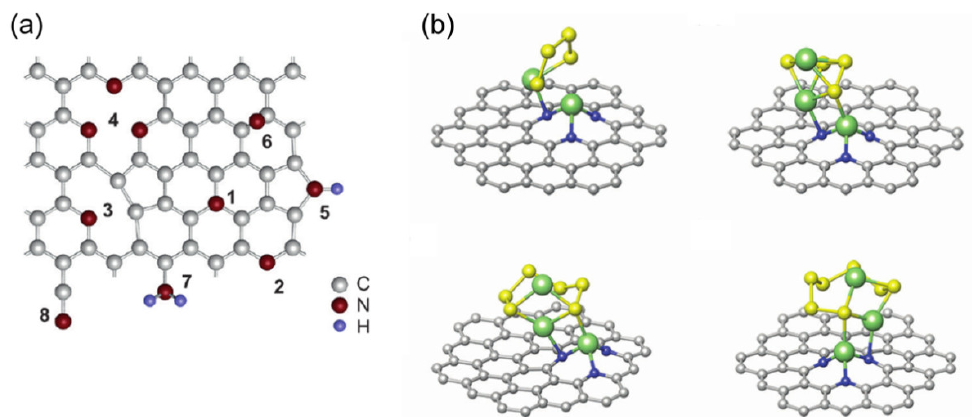
Figure 3. ( a ) Configuration of nitrogen-doped graphene: (1) graphitic-N, (2) pyridinic-N, (3) single N pyridinic vacancy, (4) triple N pyridinic vacancy, (5) pyrrolic-N, (6) interstitial N or adatom, (7) amine, (8) nitrile [72]. Copyright 2011, American Chemical Society. ( b ) The adsorption configuration diagram of LiPSs in LiNG. The gray, blue, yellow, and green spheres represent the C, N, S, and Li atoms, respectively [76]. Copyright 2017, Royal Society of Chemistry.